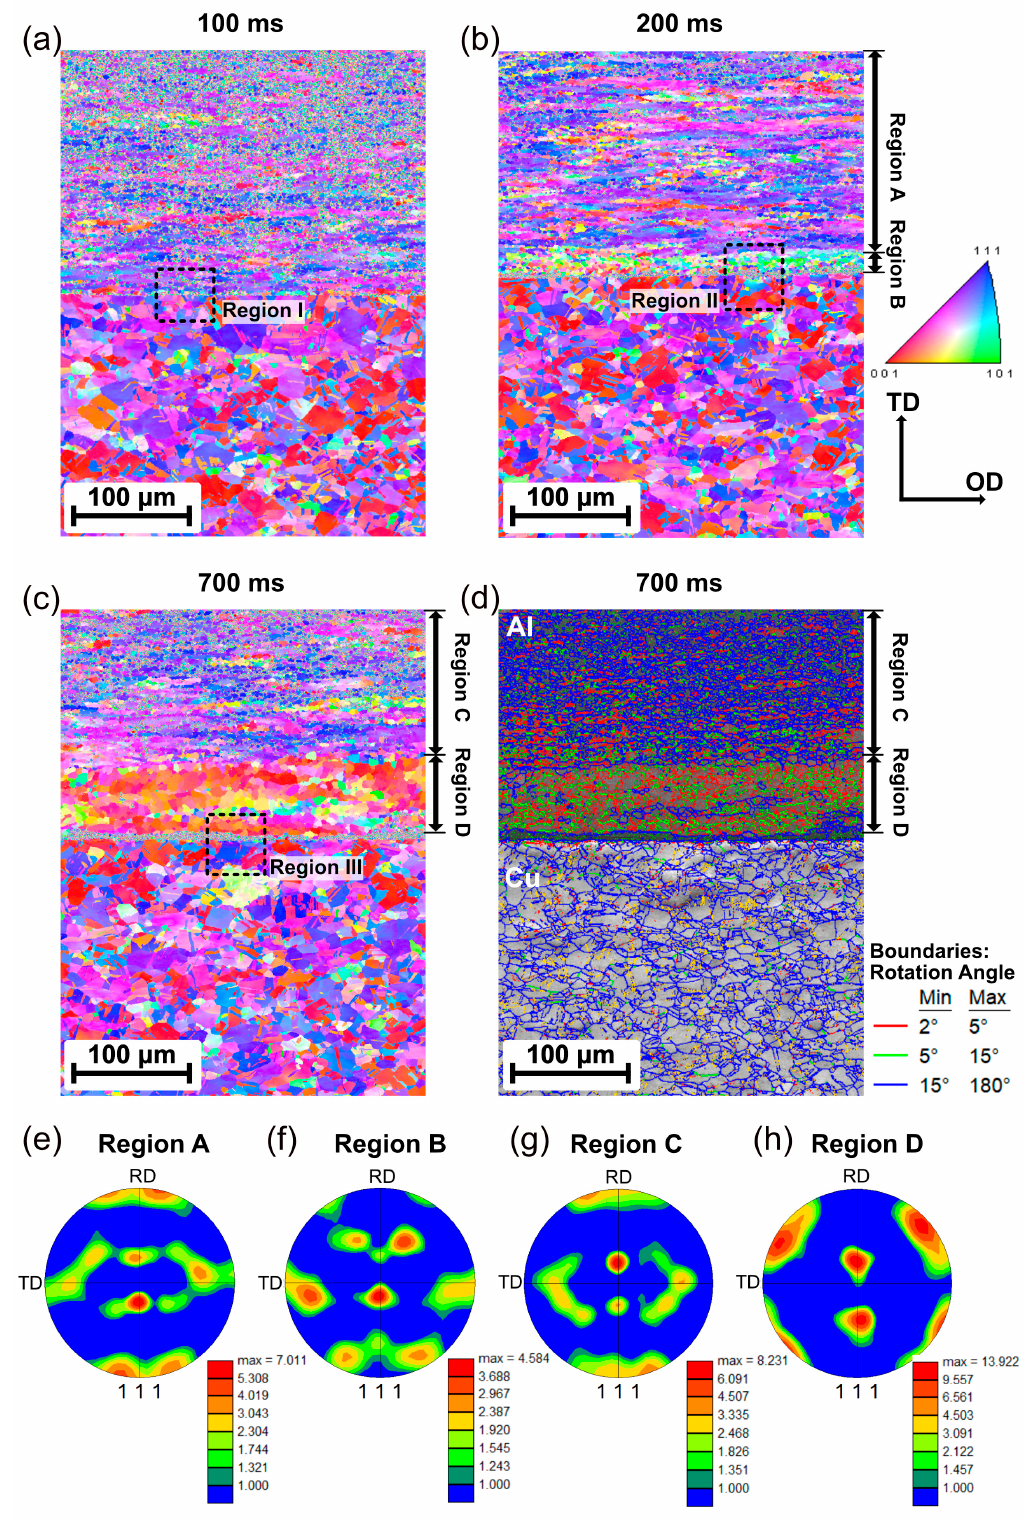
Figure 7. Inverse pole figures maps of the Al/Cu joint at different welding times: ( a ) 100 ms, ( b ) 200 ms, and ( c ) 700 ms. ( d ) Grain boundary character of ( c ); ( e – h ) {111} pole figure extracted from each region of the inverse pole figure maps.